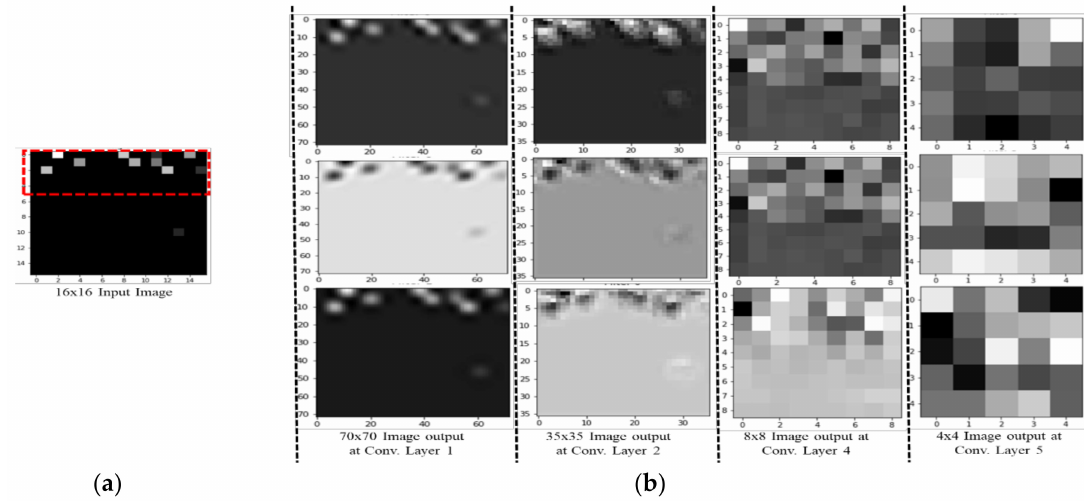
Figure 7. Images for ResNet. ( a ) Input image. ( b ) Output image with di ff erent convolutional